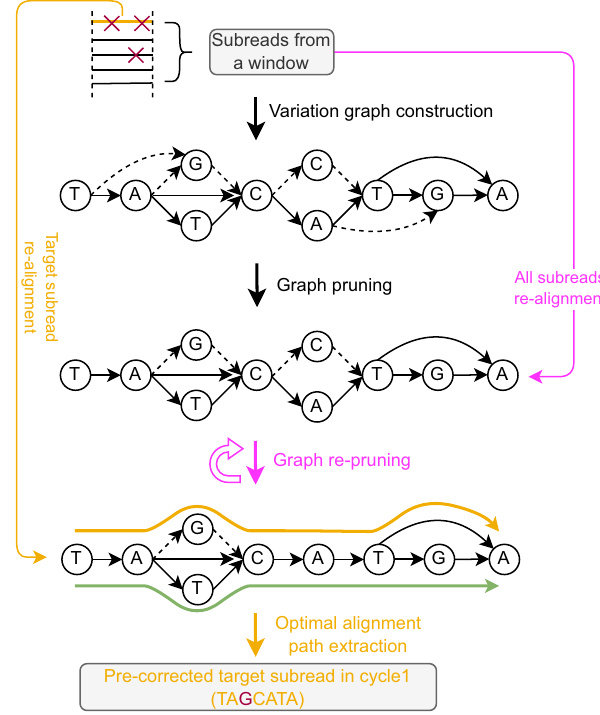
Fig. 2 | Error correction for one target subread in cycle 1. The error correction process for the target read r is illustrated assuming a diploid scenario (the orange pathrepresentstheoptimalalignmentpath,whereasthegreenpathrepresentsthe other true haplotype). “ Graph pruning ” and “ Graph re-pruning ” refer to the core error correction procedures. These procedures rely on a variation graph that is constructed from segments of a read alignment pile that results from a multiple alignment of the target read and the reads that overlap it, see Fig. 1. During graph pruning and re-pruning spurious edges (dashed arrows), induced by sequencing errors,areremovedfromthevariationgraph.Thepinkelementsindicatethatthese procedures are repeated.